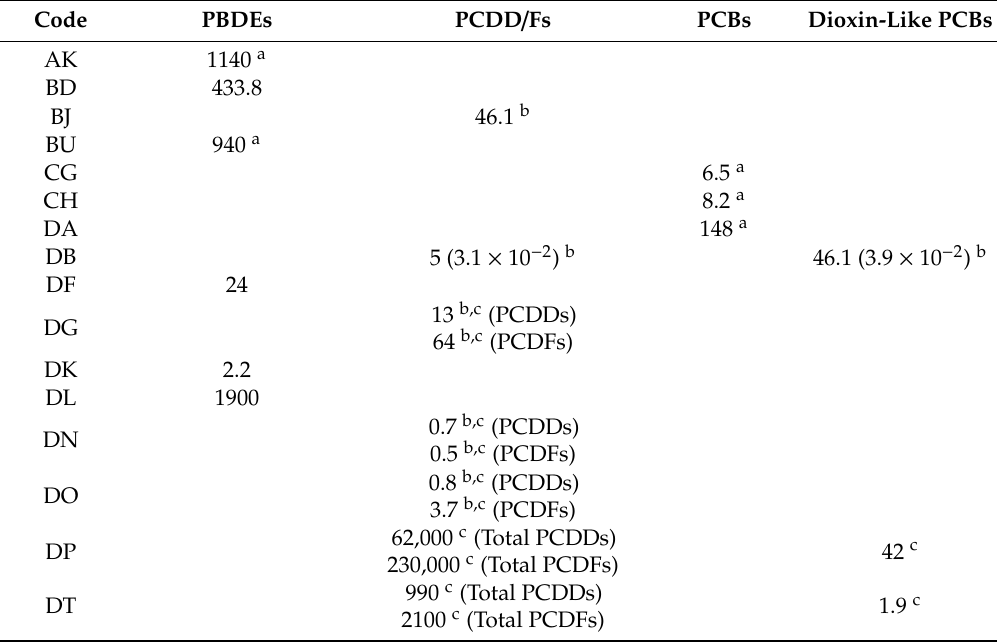
Table 7. Concentration of organic pollutants in soil (values expressed in ng /